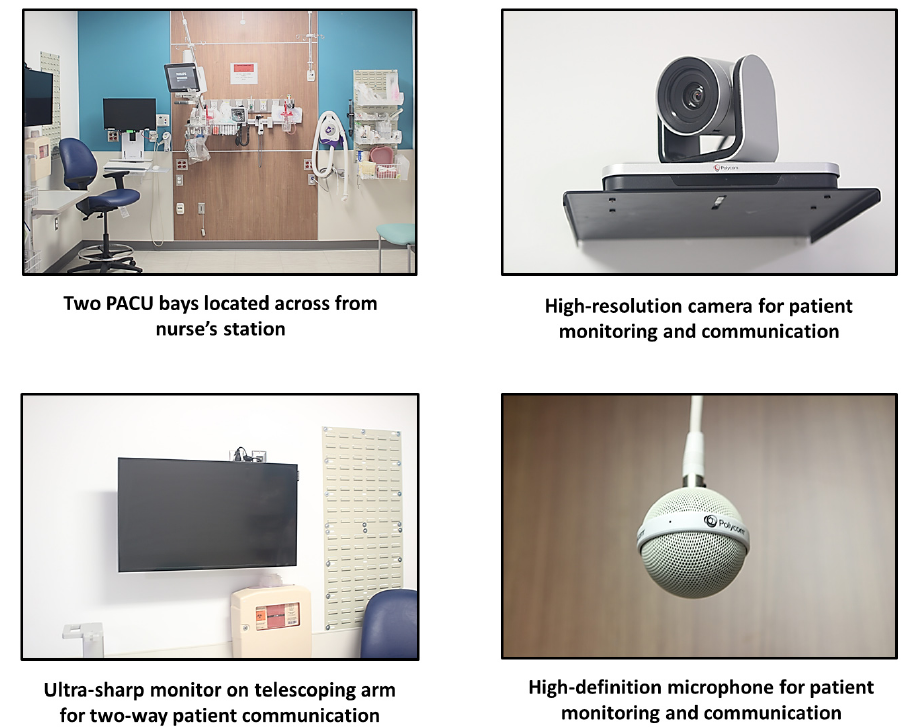
Figure 1. Image of post-anesthesia care unit bay in Barnes-Jewish Hospital with two-way video